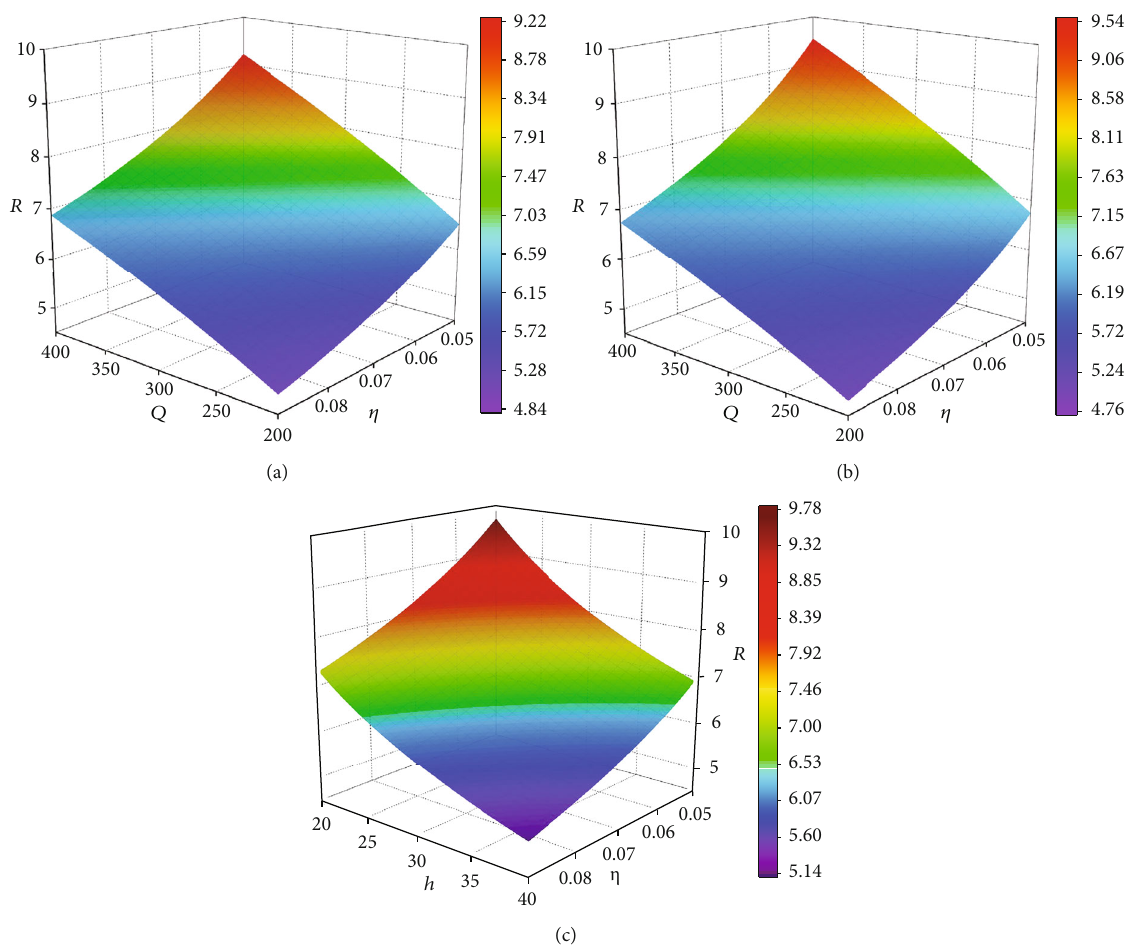
Figure 6: Analysis of the in fl uencing factors of the grouting di ff usion radius. (a) R − Q − η 3D function image. (b) R − Q − h 3D function image. (c) R − h − η 3D function